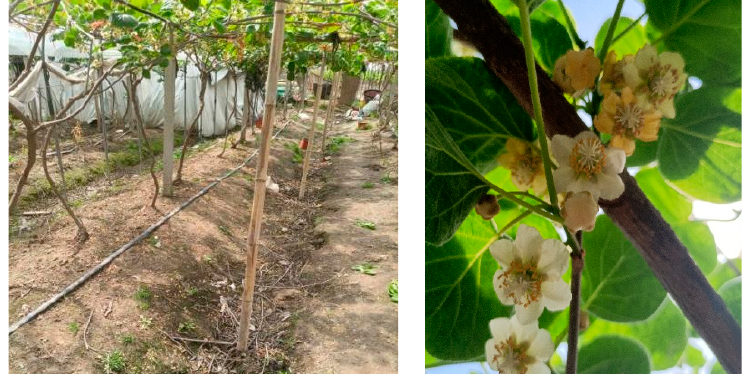
Figure 9. Test base.